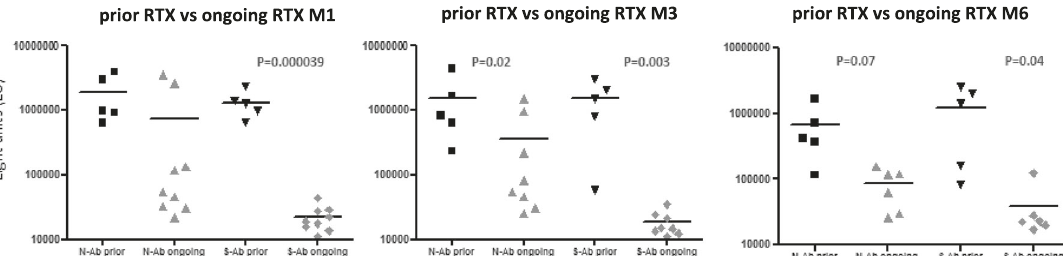
Fig. 4 Antibody levels against SARS-CoV-2 nucleocapsid and spike proteins in patients receiving prior or ongoing Rituximab treatment. Antibody levels against SARS-CoV-2 nucleocapsid (N-Ab) and spike protein (S-Ab) were determined in hematological patients receiving prior or ongoing Rituximab treatment. Comparison of antibody levels in these two groups was determined at 1 (M1), 3 (M3), and 6 (M6) months after nasal swabs became PCR-negative. Statistically signi fi cant differences in antibody levels among the sample group were determined by a Student ’ s t test.